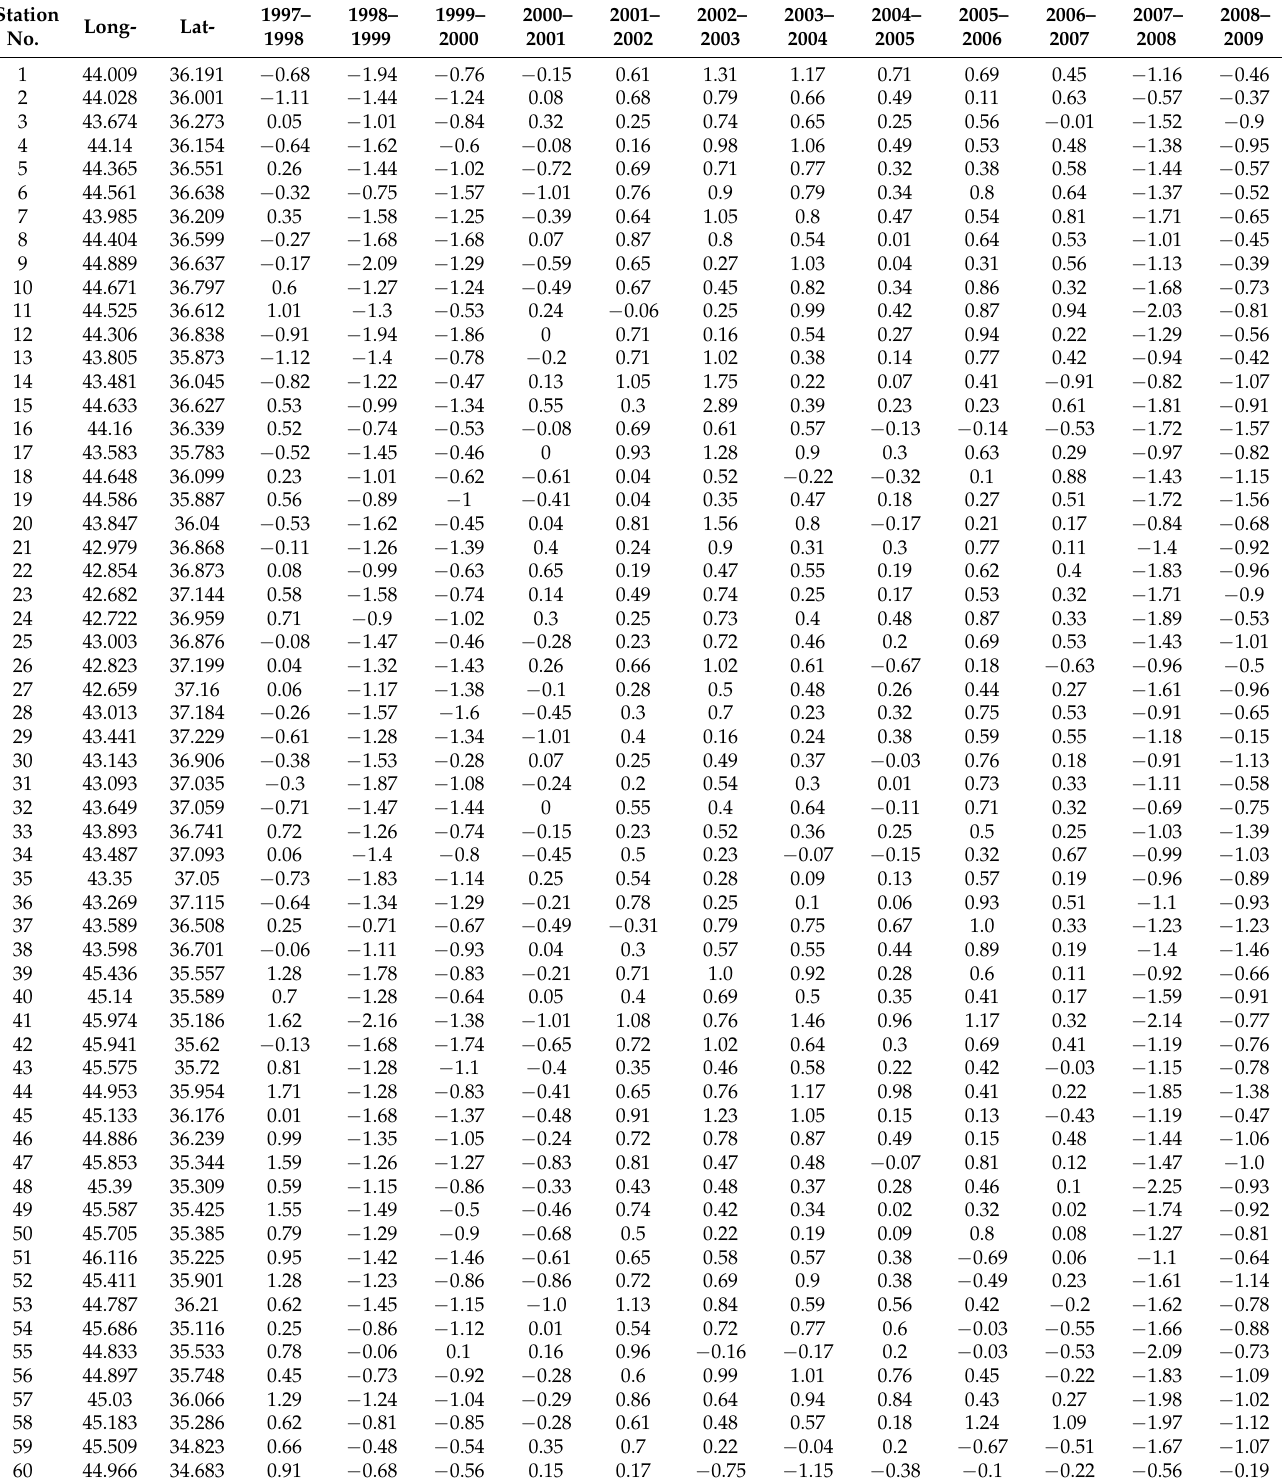
Table A3. The duration, frequency, and severity of droughts based on the SPI index in 60 weather stations in the KRI from 1998 to